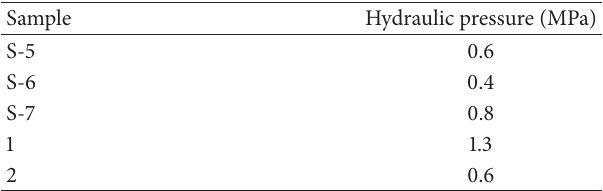
Table 5: Impermeability of concrete cores.